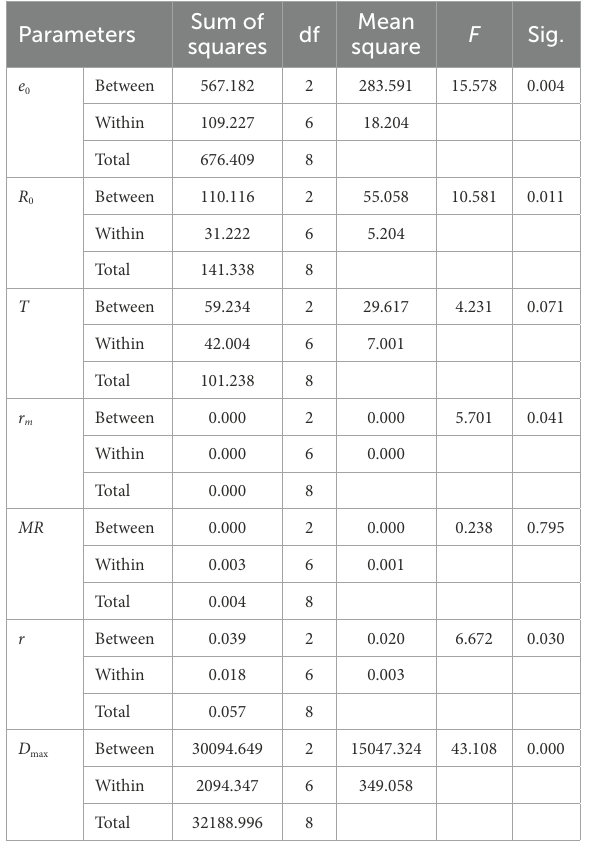
FIGURE 2 The population density in B. calyciflorus under different treatments.